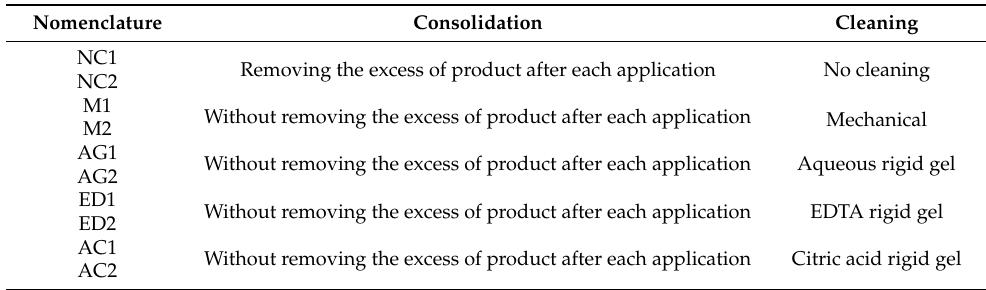
Table 1. Testing specimens and cleaning methods applied to each of